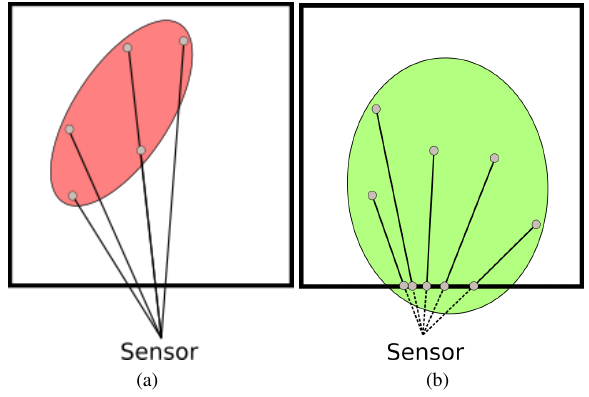
Figure 2. Calculating mean and covariance for (a) occupied space over surface points and (b) traversed space over the start- and endpoints of the rays truncated at the voxel boundaries.